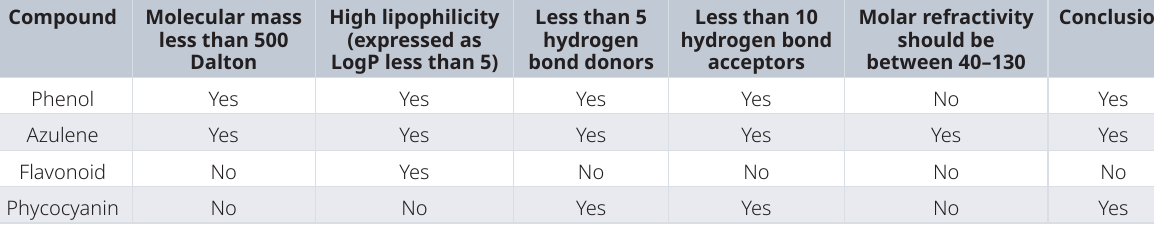
Table 3. Druglikeness property using Lipinski Rule of Five.